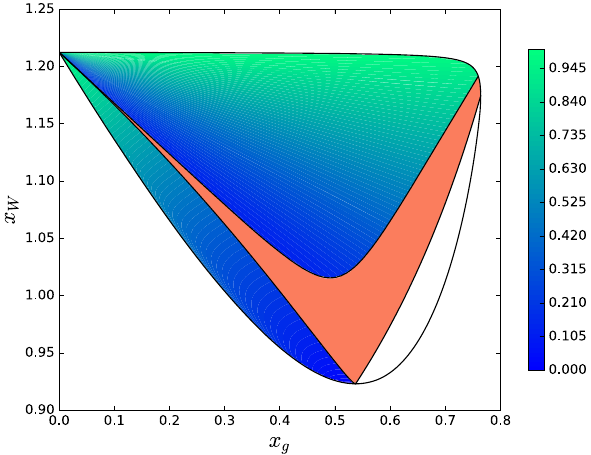
Fig. 2 Dalitz plot for t → bW + g where the gluon is emitted by the angular-ordered parton shower. The energy fractions of the gluon and W + boson are x g = 2 E g / m top and x W = 2 E W / m top , respectively. In the regions of allowed emission in the angular-ordered parton shower the plot shows the ratio of the leading-order matrix element result over the parton-shower approximation. The red region, the ‘dead-zone’, is not filledby theparton shower while theempty region for large x g could be filledby the parton shower, inpracticethe the shower provides a poor approximation in this region and it and the ‘dead-zone’ are filled using a hard matrix-element